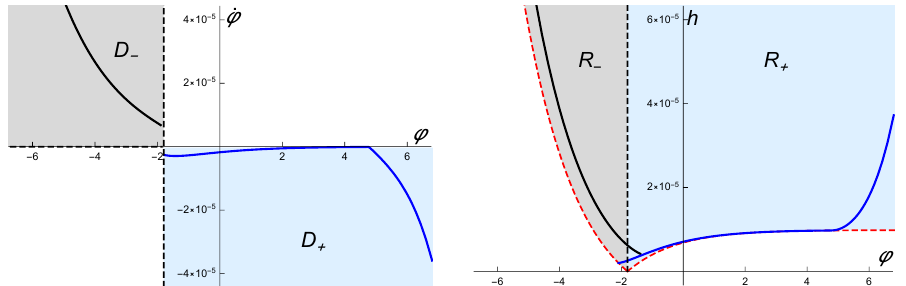
Figure 2. Regions D ± in the left plot and R ± in the right one. The black lines are representative trajectories with initial condition in D − ( left ) and R − ( right ). Analogously, the blue lines are repre- sentative trajectories with initial conditions in D + ( left ) and R + ( right ). The parameters of the model √ √ 3 2 are taken as λ = , µ = , c 1 = 2 × 10 − 10 , c 2 = 2.5 × 10 − 10 3 4